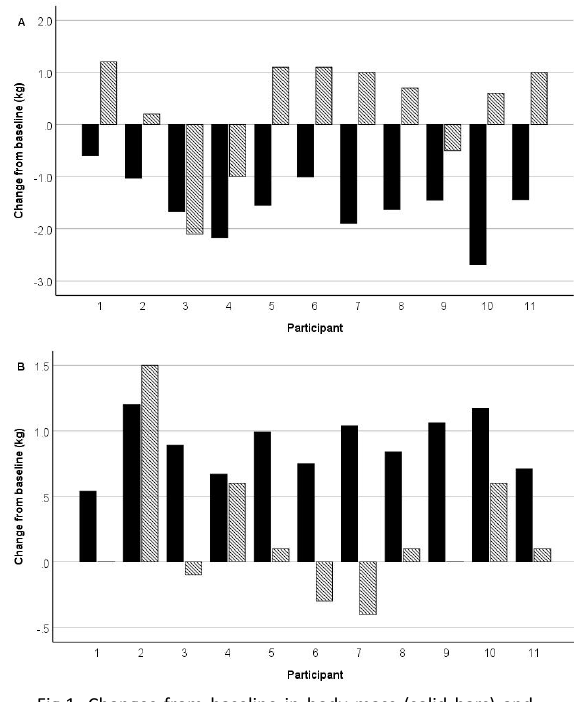
Fig.1: Changes from baseline in body mass (solid bars) and SMFBIA-estimated total body water (hashed bars) following A) dehydration and B)